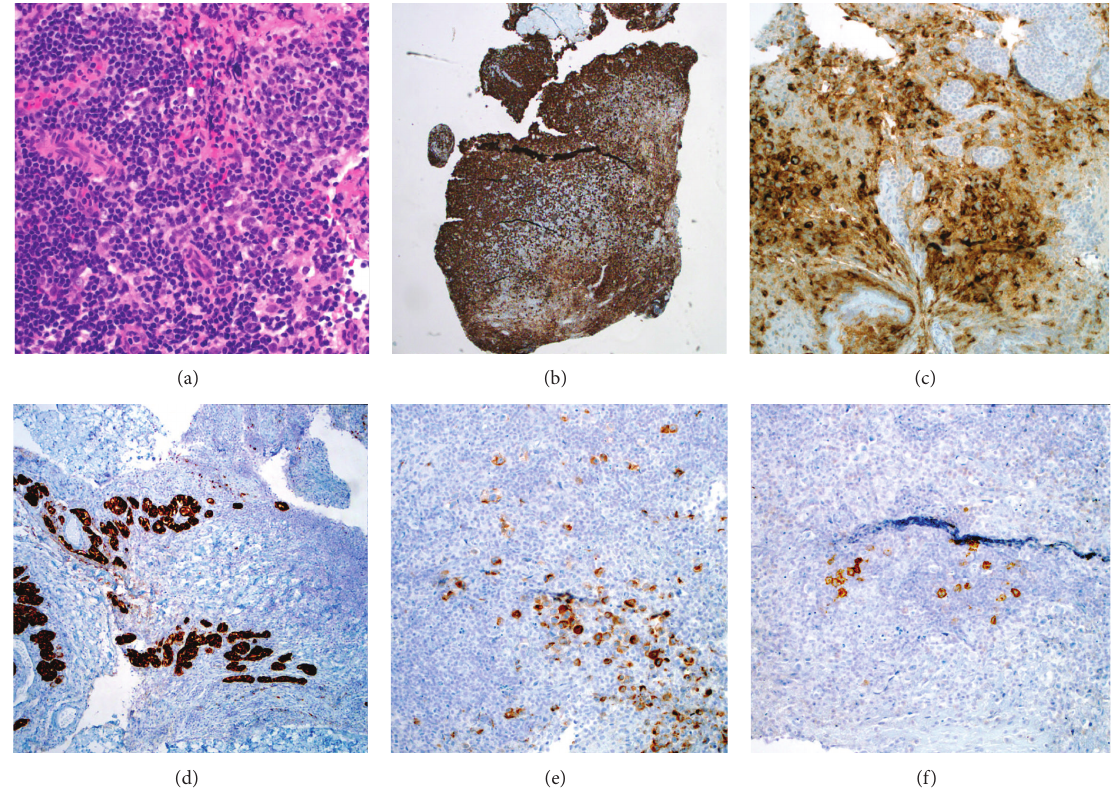
Figure 3: Biopsy of infundibulum: (a) H&E sections of lesion show sheets of small lymphocytes and clusters of larger cells (orig. mag. 20x), (b) CD3 stain of entire biopsy shows predominance of T cells (DAB, orig. mag. 4x), (c) placental alkaline phosphatase (PLAP) immunostain demonstrates that at least some of larger cells are germ cell tumors, (d) keratin immunostain shows nests of epithelial cells consistent pituitary follicles (positive synaptophysin not shown) (DAB orig. mag. 10x), (e) keratin stains also show individual positive cells in area of germ cell tumor, suspicious for an embryonal carcinoma component (DAB, orig. mag. 20x), and (f) CD30 stains confirm presence of embryonal carcinoma component (DAB, orig. mag.